Question: In one sentence, what is this figure communicating?
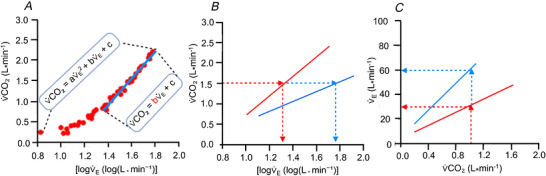
Answer: Semi‐log transformation of the V ˙ C O 2 – V ˙ E relationship A , representative V ˙ C O 2 –log V ˙ E trajectory from a real test, illustrating the transition from a curvilinear to a linear segment. The slope of this linear portion (coefficient b ) defines the empirical V ˙ C O 2 –log V ˙ E relationship used for analysis (blue line). B , interpretation of the semi‐logarithmic domain. The arrows quantify how much ventilation is required for a given CO 2 output rather than labelling axes. To read the plot, fix a target V ˙ C O 2 (horizontal reference), follow it until it intersects the red (e.g. man) and blue (e.g. woman) regression lines, and project to the x ‐axis to obtain log V ˙ E , then convert to V ˙ E ( V ˙ E = 10^log V ˙ E ). For example, at V ˙ C O 2 ≈ 1.5 L min − 1 , the red line may intersect at log V ˙ E ≈ 1.30 ( V ˙ E ≈ 20 L min − 1 ), whereas the blue line intersects at log V ˙ E ≈ 1.75 ( V ˙ E ≈ 56 L min − 1 ). Thus, for the same CO 2 output, the red slope entails less ventilation – indicating greater ‘ventilatory efficiency’ in the semi‐log domain. C , conventional linear V ˙ E – V ˙ C O 2 representation. Here, the arrows again ask ‘how much ventilation for a given CO 2 ?’ but the axes are inverted: V ˙ C O 2 is fixed on the x ‐axis and V ˙ E is read on the y ‐axis at each intersection. For instance, at V ˙ C O 2 ≈ 1.0 L min − 1 , the red line yields V ˙ E ≈ 35 L min − 1 , whereas the blue line gives ≈ 60 L min − 1 – requiring greater ventilation and hence lower ‘efficiency’. These paired readings emphasize that interpretation in ( B ) is inverse to ( C ): a steeper slope in ( B ) implies higher ‘efficiency’ (less V ˙ E for the same V ˙ C O 2 ), whereas a steeper slope in ( C ) implies lower ‘efficiency’ (more V ˙ E for the same V ˙ C O 2 ). The term ‘efficiency’ in this paper is used comparatively, relative to the maximal theoretical slope (see Efficiency Calculation section).